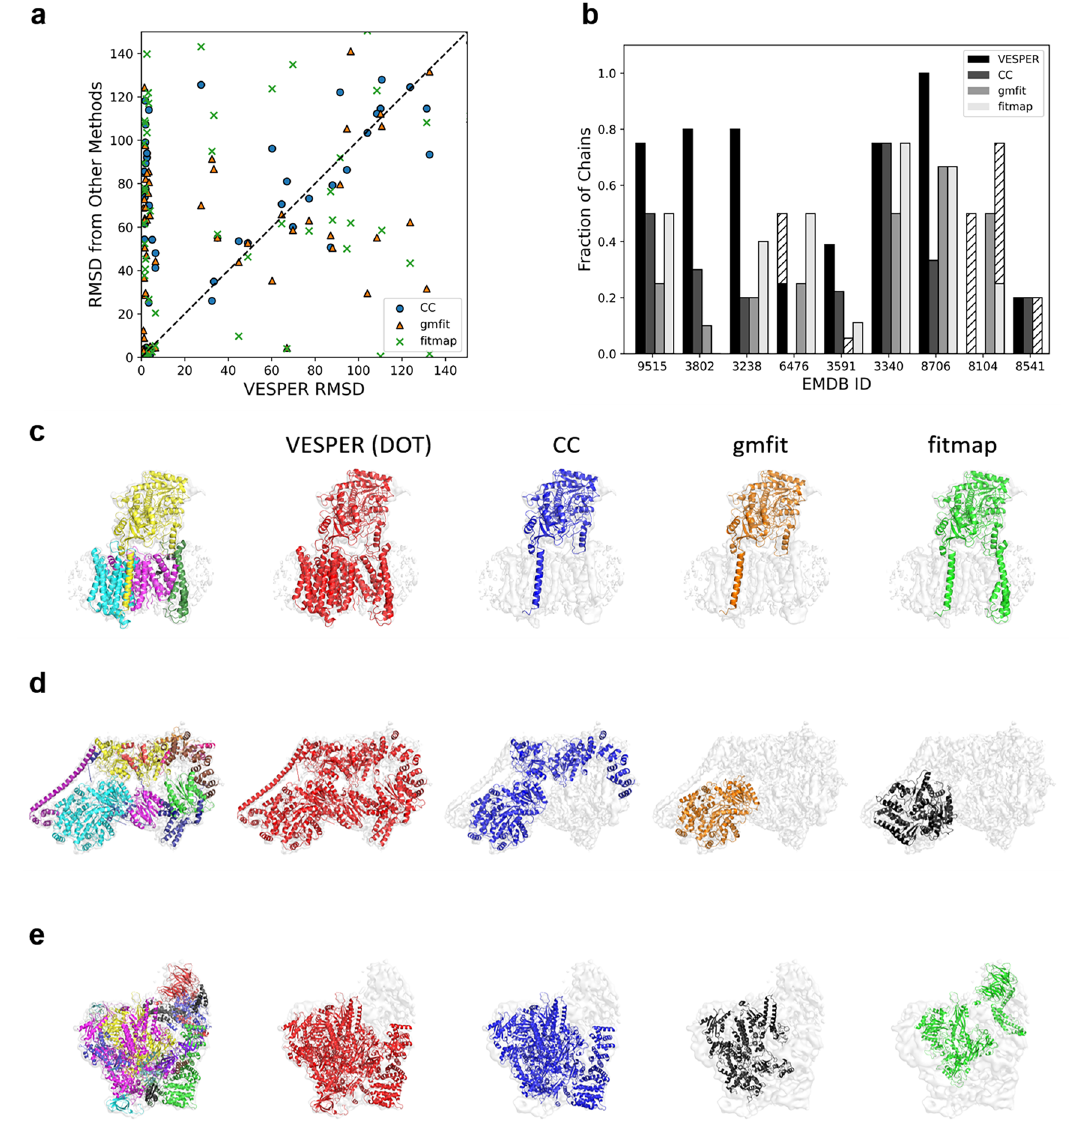
Fig. 5 Performance of atomic model fi tting. a Comparison of RMSD of the alignment with the best score by VESPER (DOT) with CC, gm fi t, and fi tmap. EM maps in the dataset are listed in Table 3. A voxel spacing of 3 Å and a rotation angle of 10° were used in Fig. 4. Supplementary Fig. 4 provides results for the other three parameter combinations. Blue circles, comparison against CC; orange triangles, gm fi t; green crosses, fi tmap, respectively. b The fraction of query chains for each map that had the top-scoring alignment with an RMSD of 5.0 Å or less (solid gray bars) and 10.0 Å or less (including hatched bars). Black bars, VESPER (DOT); dark gray, CC; medium gray, gm fi t; pale gray, fi tmap. c Chain structure fi tting for fi ve chains of γ -secretase (EMD-3238, PDB ID: 5fn3). The left panel shows superimposed structures of 5fn3 in the map. Each chain is in different color. From the second to the last panel from the left, chains placed within an RMSD of 5.0 Å are shown for VESPER (DOT), CC, gm fi t, and fi tmap, respectively. The number of chains placed within the cutoff was 4, 1, 1, and 2 chains by these methods, respectively. d Chain structure fi tting of transcription factor IIH (EMD-3802, PDB ID: 5of4). There are 10 chains to fi t. VESPER (DOT), CC, gm fi t, and fi tmap placed eight (A, B, E, F, H, X, Y, Z), three (A, B, Y), one (B), and zero chains within 5.0 Å RMSD, respectively. Chain IDs are taken from the PDB fi le. For fi tmap, the placement of chain B, which had an RMSD of 37.7 Å is shown, since this chain had the smallest RMSD among the other chains. e fi tting of 18 chains of RNA polymerase I-Rrn3-CF complex (EMD-3591, PDB ID: 5n5z). Within 5.0 Å RMSD, VESPER (DOT), CC, gm fi t, and fi tmap placed seven (A, B, C, E, G, H, O), four (A, B, C, O), zero, and two (B, P) chains, respectively. For gm fi t, chain A that was fi t at an RMSD of 9.0 Å is All maps were resampled to the grid spacing of 3Å. 100 alignments were computed on surface points identi fi ed by mean fi lter on binary mask (NVM); Normal vector for each pair of maps by shifting and rotating maps using the translation and angle score on all points at an iso-contour level (NVA); Normalized variants of CDT, de fi nition used in the ALCPS score 8 . ALCPS is de fi ned as ALCPS = 2 π r θ /360, where r CDM, & CDA (CDT_GDT), (CDM_GDT), (CDA_GDT); SMOC, SCCC, LMI are combined with OVR (SMOC_OV), (SCCC_OV), (LMI_OV). These scores were is the translation and θ is a rotation angle from the correct superimposition, which was computed with the TEMPy program 35 . de fi ned by the superimposition of the associated protein structures using MM-Align 30 . The alignment dataset was computed for 26 map pairs provided in the Table 1 of For an alignment set for a map pair, correct alignments were de fi ned in two metrics, the paper by Joseph et al. Two map pairs from the table were excluded from our RMSD and log(ALPCS). When RMSD was used for evaluation, 10Å was used as the dataset because de fi ning the correct alignment was not possible since the associated cutoff to de fi ne correct alignments. For log(ALCPS), cutoffs were de fi ned differently atomic detailed structures from PDB do not suf fi ciently overlap with the density maps. for the three categories, which were − 0.4, 0.82, and − 0.5, for the Other, Ribosome,